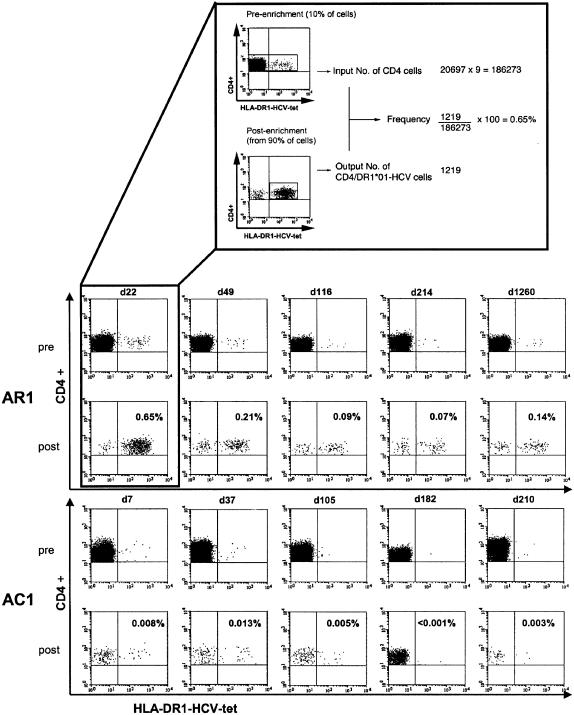
Examples of ex vivo HLA-DR1-HCV-1806-1818 tetramer staining from the acute hepatitis C cohort.PBMC from one acute resolving patient (AR1) and one patient with acute hepatitis C and chronic evolution (AC1) were stained with the HLA-DR1-HCV-1806-1818 tetramer as described in the methods. For each patient the upper panels represent pre-enrichment stainings and the lower-panels the post-enrichment stainings. The numbers in the upper right corner of the post-enrichment panels are calculated according to the input CD4+ T cell number. The insert on top of the figure shows in detail the calculation method. These figures are plotted over time in both cases in Figure 2 (lower panels).